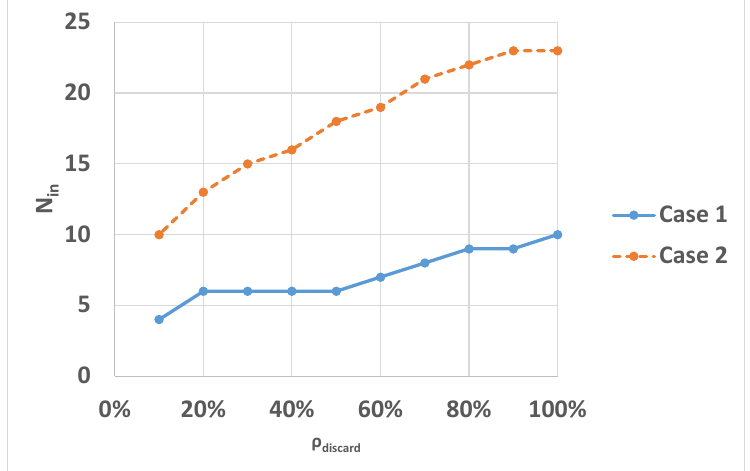
Figure 8. Variation of the optimal N in in terms of the discard rate: case 1 vs. case